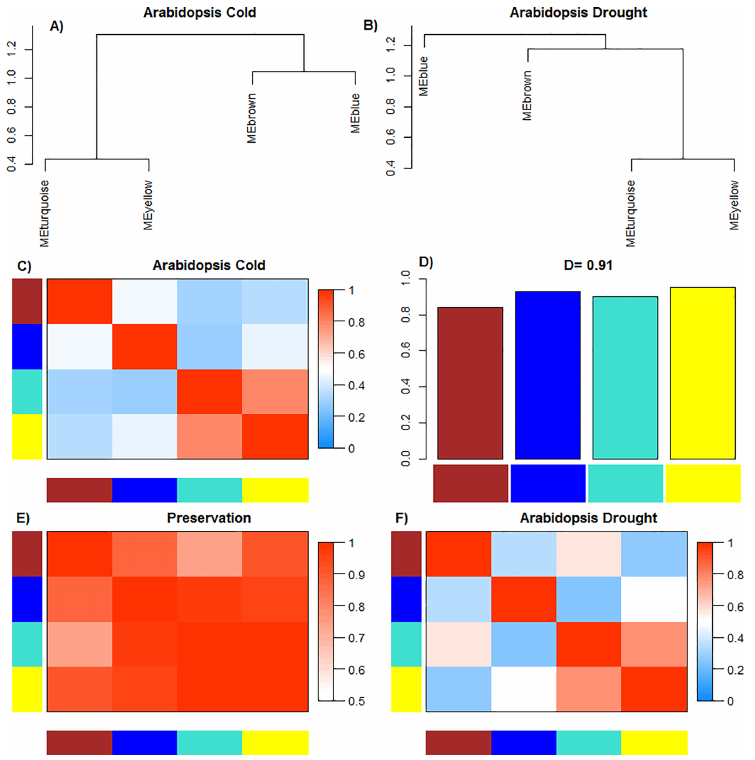
Fig 7. Differential consensus module eigengene analysis between cold and drought consensus module eigengene networks. Differential eigengene network analysis was used to address the strength of the correlation preservation for all eigengene pairs across the two networks: (A) and (B) Clustering dendrograms of consensus module eigengenes (ME) showing the presence of meta-modules as depicted by the presence of same major branching pattern in both cold and drought eigengene network dendrograms. (C) and (F) Heatmaps of eigengene adjacencies in each of the consensus eigengene networks for cold and drought dataset respectively. Each of the rows and columns represents an eigengene tagged by the consensus module color and within the heatmap, red color represents high adjacency and positive correlation, whereas blue represents low adjacency and negative correlation, as represented by the color legend. (D) Bar plot depicts the preservation measure for each consensus eigengene as the height of the bar (y-axis) where each colored bar corresponds to the eigengene of the associated consensus module. The high-density value D(Preserv Drought,Cold ) = 0.91 indicates the high overall preservation between the two networks. (E) Heatmap representation of Adjacencies of the pair-wise preservation network (Preserv Drought,Cold ); high values of (Preserv Drought,Cold ) implies that there is a strong correlation preservation between pairs of module eigengenes across the two networks. Each column and row represented by consensus module eigengene with the saturation of red color showing adjacency according to the color